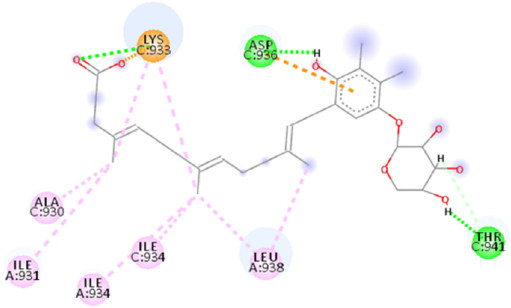
Figure 13. Calculated 2D interactions of marine_160925_88_2 in complex with SARS-CoV-2’s HR1 domain.